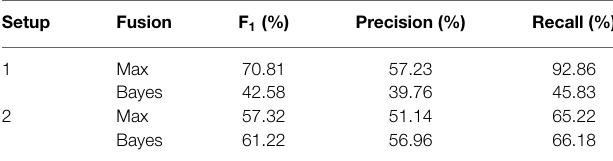
TABLE 4 | Sensor fusion of setup 1 and 2 with different fusion